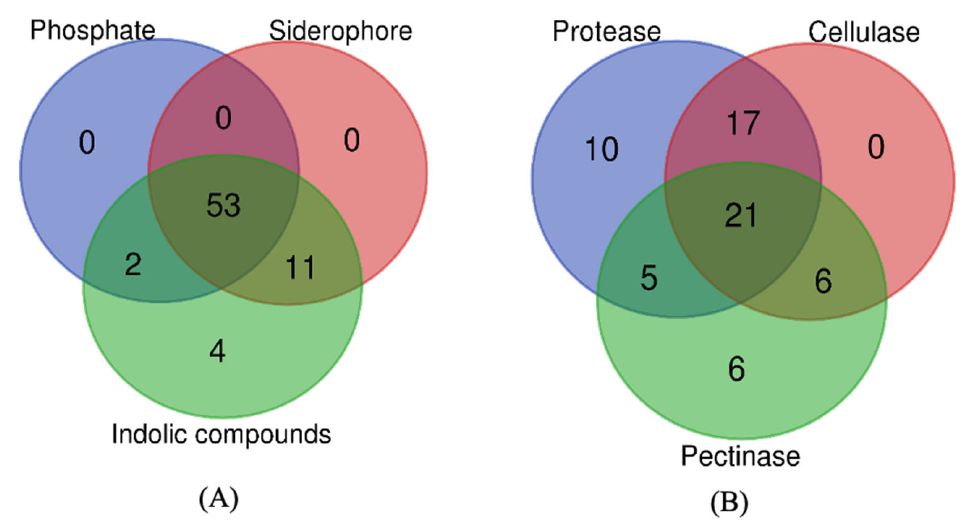
Figure 4. Venn diagram representation of the plant-growth-promoting traits ( A ) and enzyme activity ( B ) of bacterial endophytes from tea leaves.